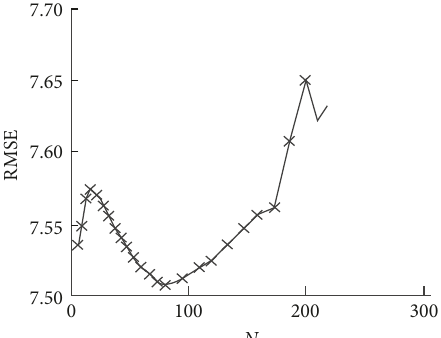
Figure 3: Effect of Gaussian filter window scale on the performance of SSIM algorithm.